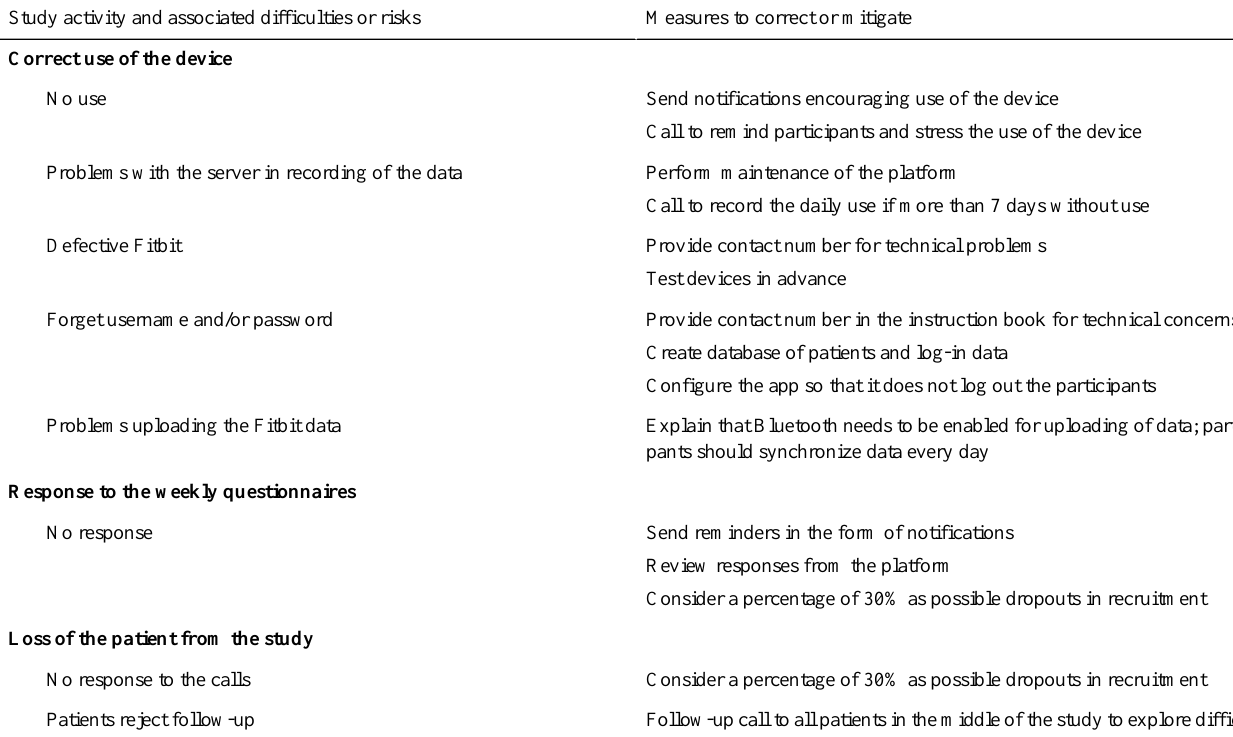
Table 4. Difficulties associated with monitoring during the study and related correction measures.